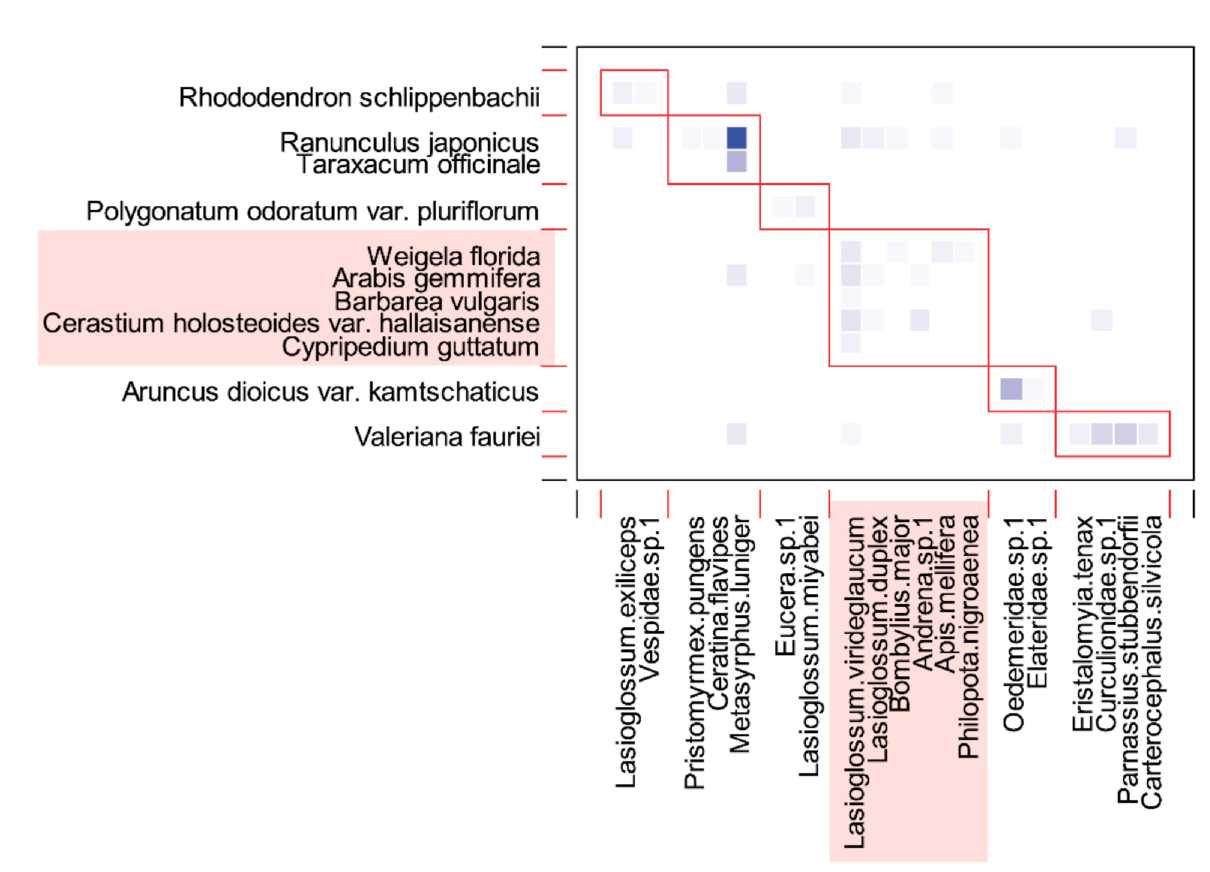
Figure 5. Modules identified by the QuanBiMo algorithm in the Cypripedium guttatum community of the Manhangjae habitat. Plants and pollinators are arranged in rows and columns, respectively. The boxes with red border lines indicate the modules, which total six. Each square with a color gradient indicates the interaction strength, with darker colors representing more frequent interactions. Component species in the module to which C. guttatum belongs are represented as rectangular boxes, colored pale